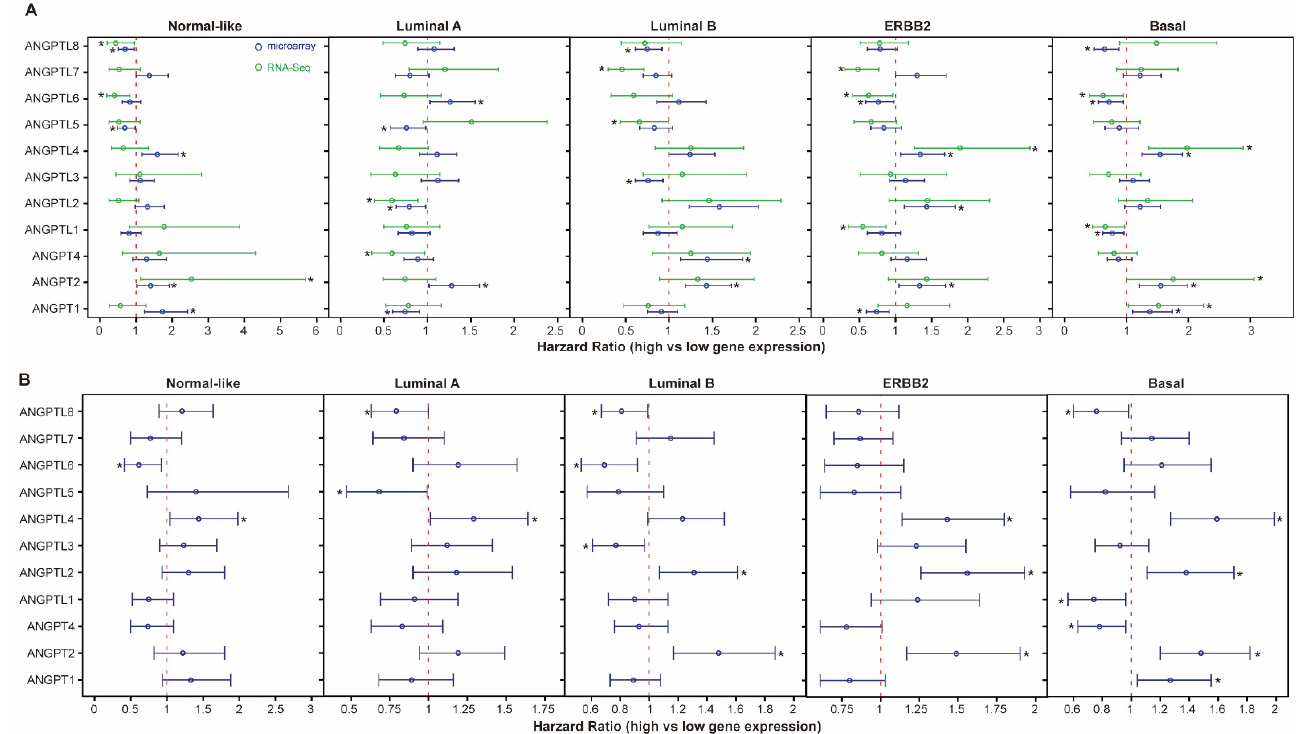
Figure 5 . Prognostic impact of ANGPT / ANGPTL genes in different molecular subtypes. ( A ) Association between ANGPT / ANGPTL genes and OS in each molecular subtype. ( B ) Association between ANGPT / ANGPTL genes and DMFS in each molecular subtype. Open circles indicate hazard ratio (HR) and bars represent 95% confidence interval (CI) of HR. * Indicates p < 0.05. HR, 95% CI, with p -values obtained from univariate Cox regression analysis.